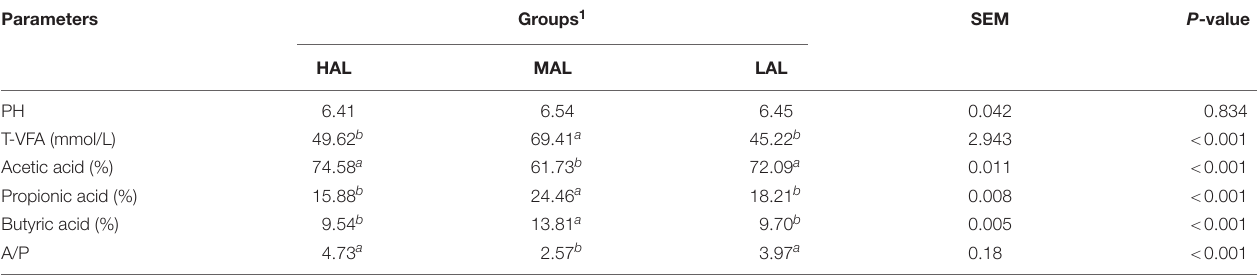
TABLE 1 | Effect of regions located at distinct altitudes on yak rumen fermentation parameters. Parameters Groups 1